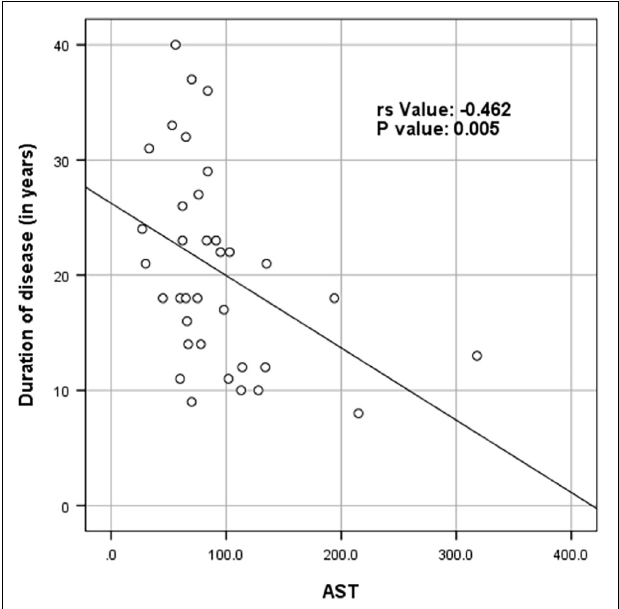
FIGURE 5 | Scatter plot diagram of correlation between duration of disease (in years) and AST ( N = 53).